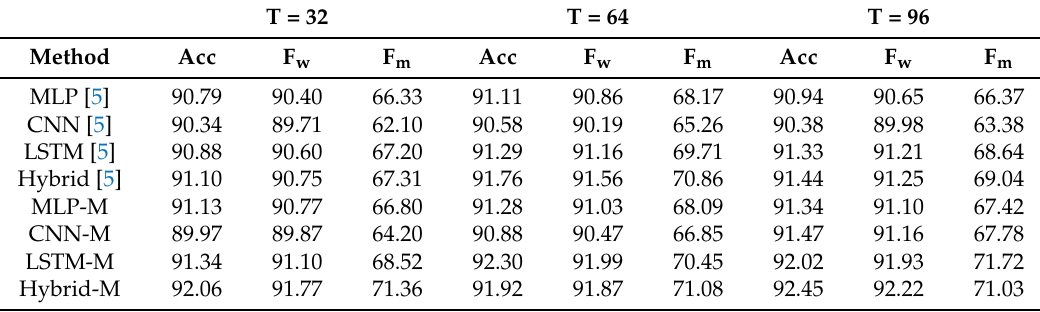
Table 4. Classification performance results (in percent) using different sliding window lengths on the OPPORTUNITY